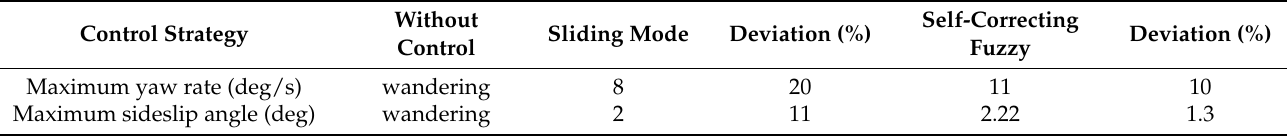
Figure 18. Simulation results of the distributed drive control at the sinusoidal line shift condition: ( a ) Speed; ( b ) Torque ( c ) Yaw Rate; ( d ) Side Slip Angle; ( e ) Lateral Acceleration. Table 7. The maximum values of the main control parameters under the sinusoidal line shift condi- tion.